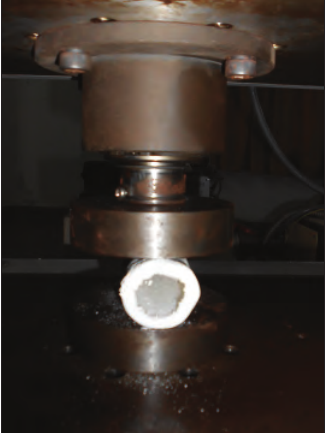
Figure-3: Compression testing performed on plaster of Paris